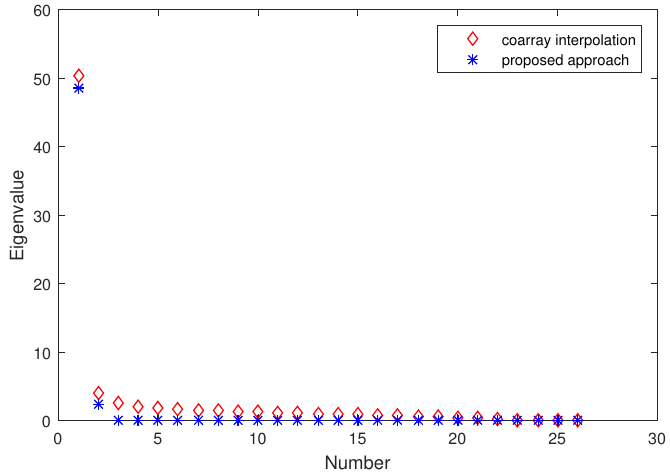
Figure 5. Sorted eigenvalues in the presence of two close sources. There are Q = 2 sources located on − 0.4 ◦ and 0.6 ◦ . The number of snapshots is K = 200 and SNR is 0 dB. The regularization parameter is set as µ = 0.15.